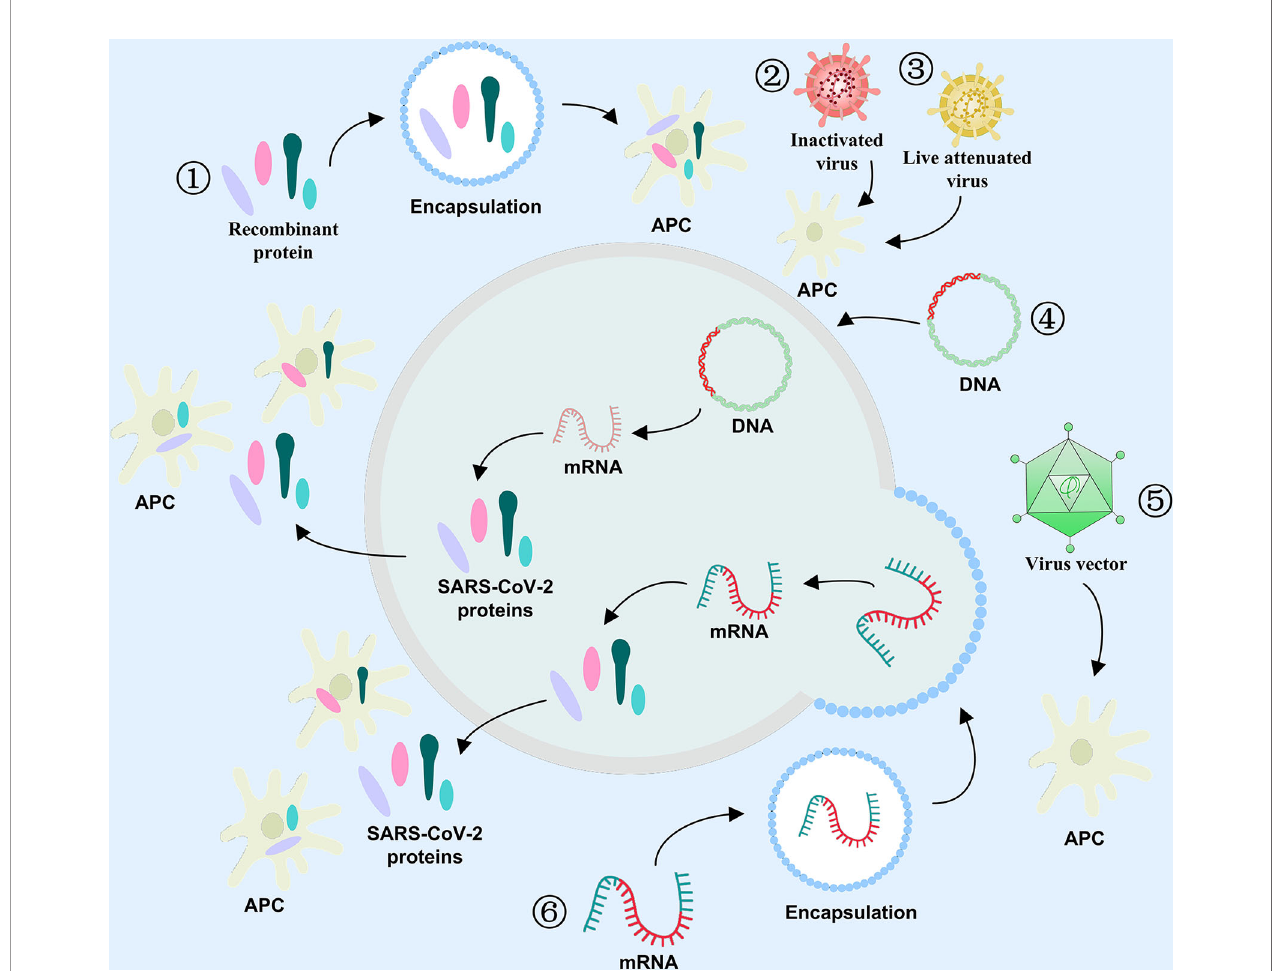
FIGURE 4 | Antigen selection for COVID-19 vaccines. The role of varying antigens in immune response against COVID-19 ① Recombinant protein, ② Inactivated virus, ③ Live attenuated virus, ④ DNA, ⑤ Viral vector, and ⑥